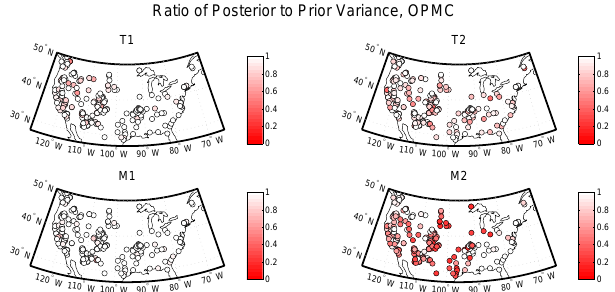
Fig. 3. Ratio of posterior to prior variance for the four growth re- sponse parameters as a measure of Bayesian learning in the pseu- doproxy experiment with SNR=1. The color scale is calibrated so that sites with values of the ratio greater than/equal to one/less than one have blue/white/red coloration.